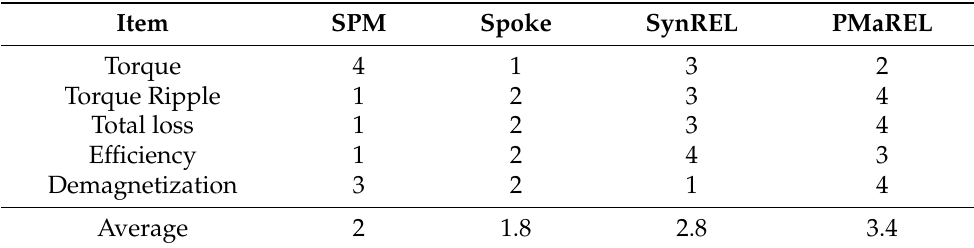
Table 5. The ranking of all